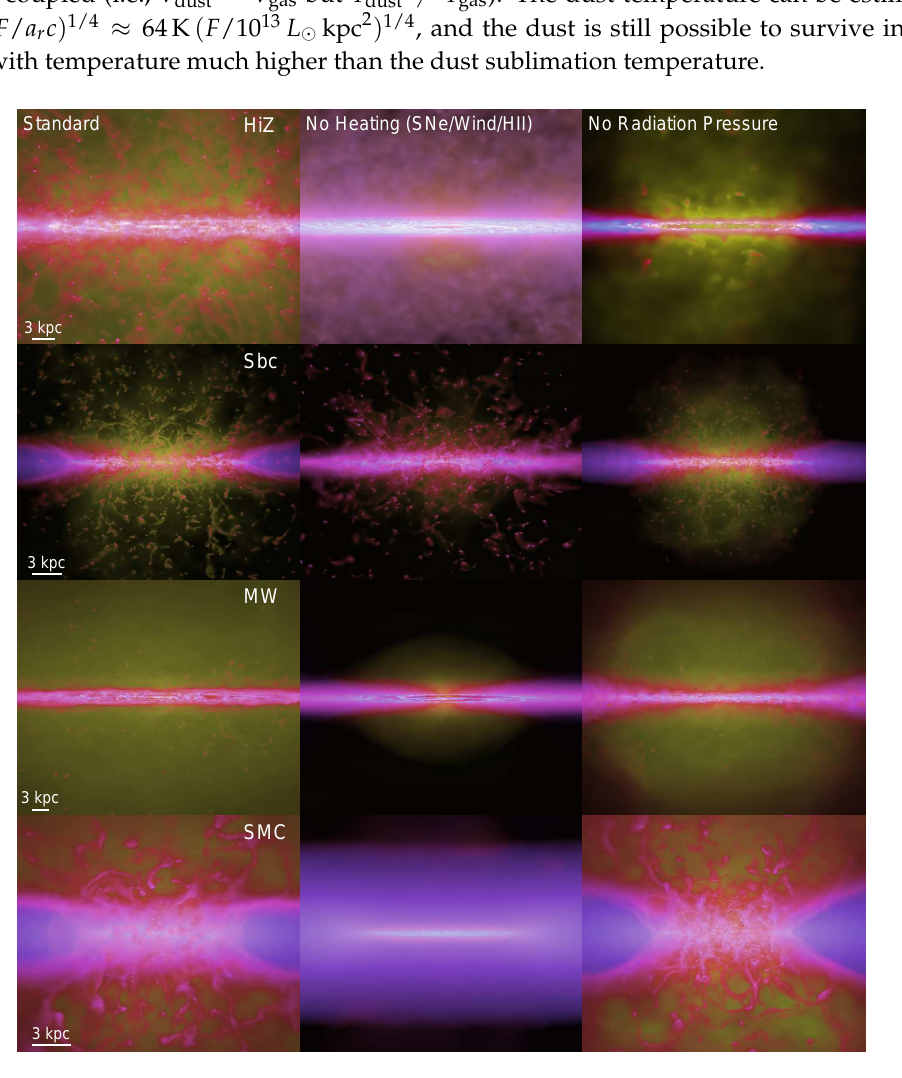
Figure 5. The relative importance of SN, stellar wind and HII heating, and radiation pressure on dust in galactic winds. Edge-on gas morphologies of winds from: High-redshift (Hiz), starburst (Sbc), Milky Way-like (MW) and Small Magellanic Cloud (SMC)-like galaxies, with different feedback implemented. ( Left ) standard model with all feedback mechanisms turning on. ( Middle ) turning off heating from SN, stellar winds and HII photoionization. ( Right ) turning off radiation pressure momentum injection. Figure reproduced with permission from Hopkins et al. MNRAS, 2012